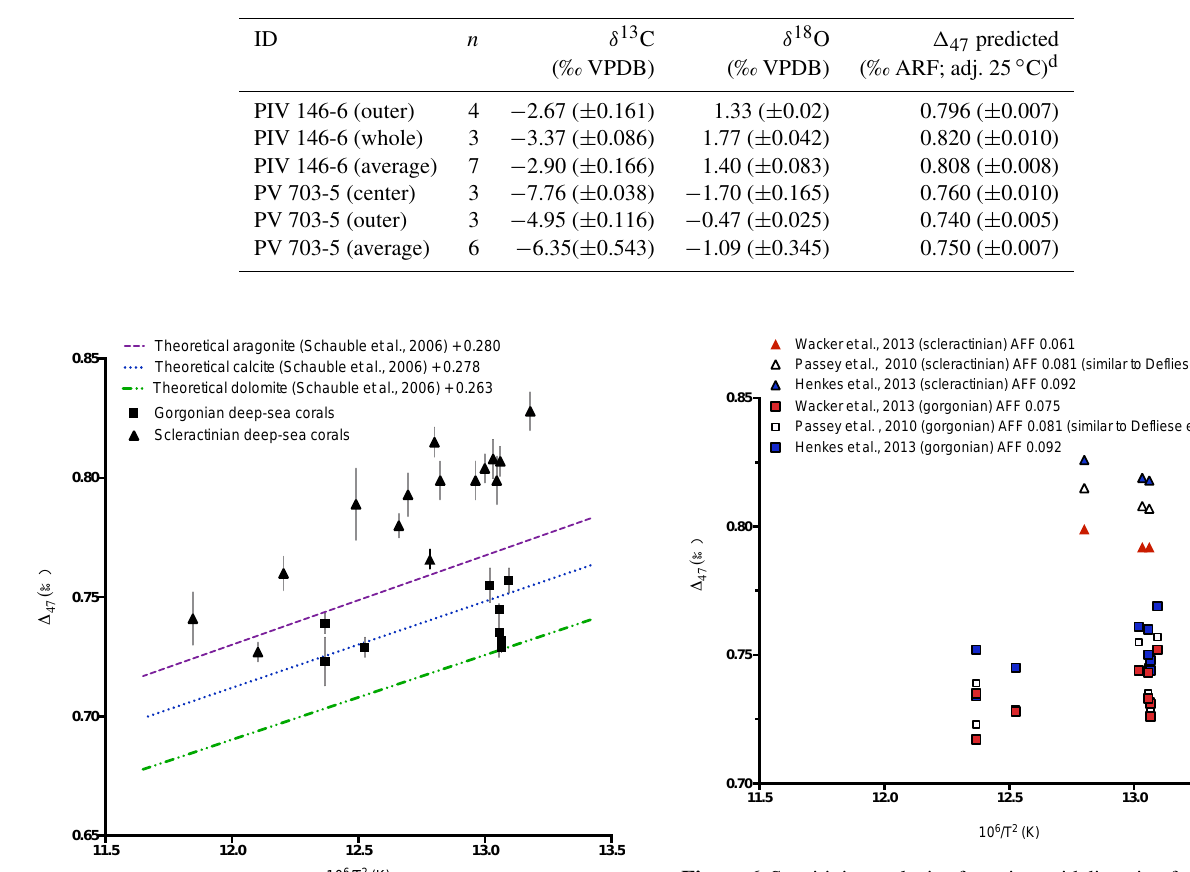
Table 5. Two coral specimens were analyzed using different portions of their skeletons. PIV 146-6 was sampled by micromilling the outer portion of a disk (outer) as well as grinding an entire disk (whole). PV 703-3 was micromilled in both cases but was milled in both the center and outer portion of a disk. All data and averages are reported as well as standard error, 1 σ .